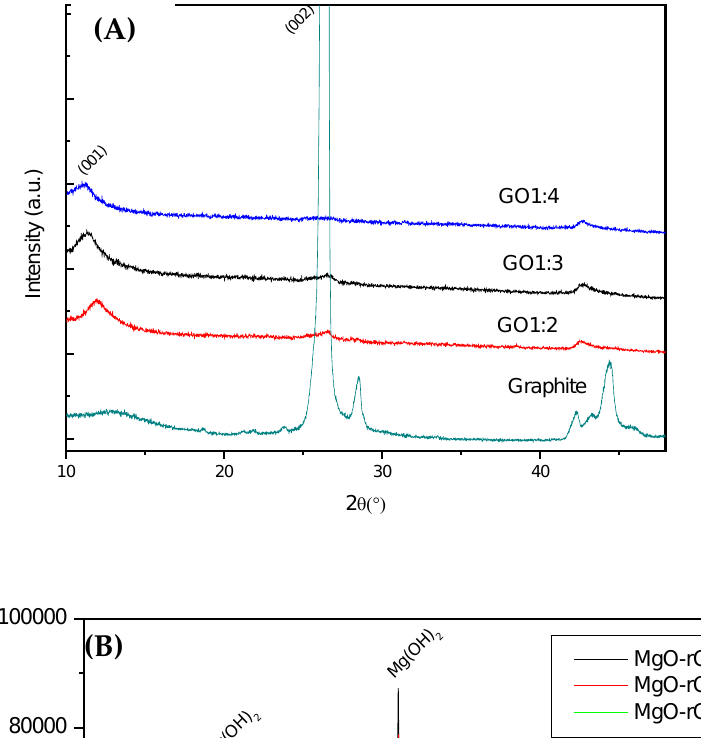
Table 1. XRD peak identification of MgO – rGO nanocomposite.